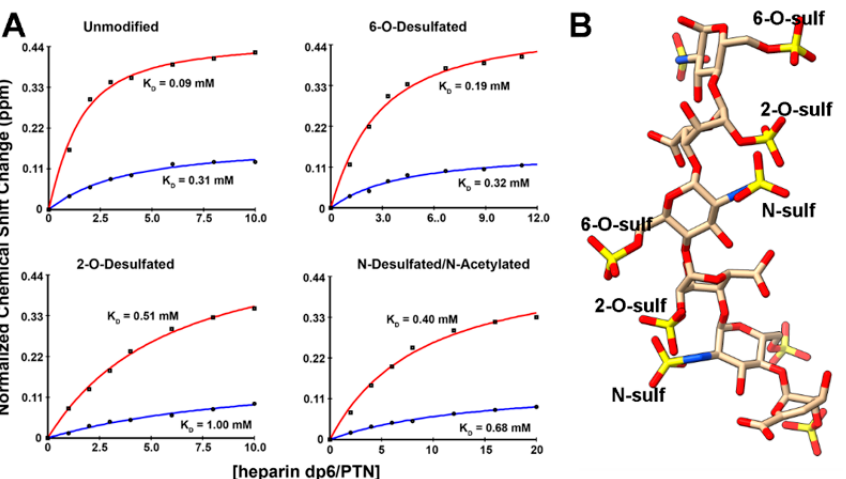
Figure 5. Effects of selective desulfation of heparin dp6 on its interactions with PTN. ( A ) Binding curves and apparent Kd of PTN residues T34 (blue, NTD) and N96 (red, CTD) when titrated with either unmodified or selectively desulfated heparin dp6. ( B ) Structure of DP6-C with the IdoA2S in the 1C4 conformation and glycosidic dihedral angles set to the minimal energy values.